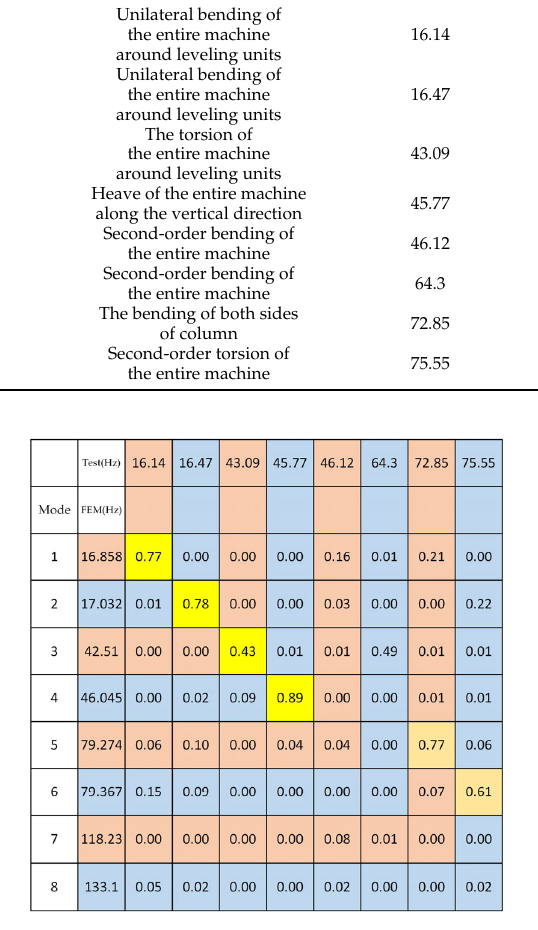
Figure 14. MAC diagram of mode shapes between the simulation and the experiment. In the process of model parameter optimization, the convergence criterion is defined